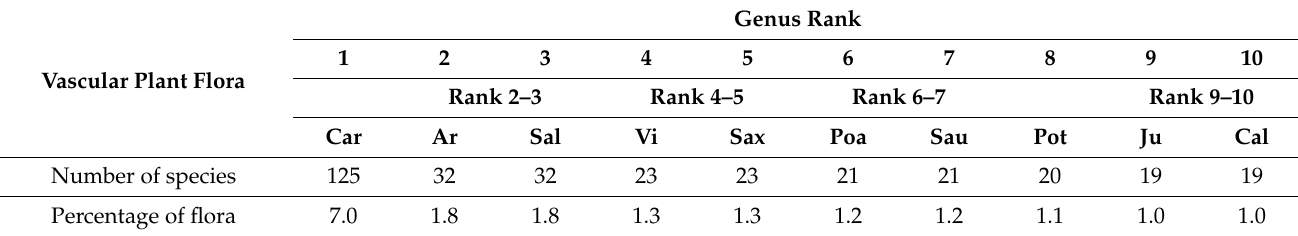
Table 2. Structure of the head genera